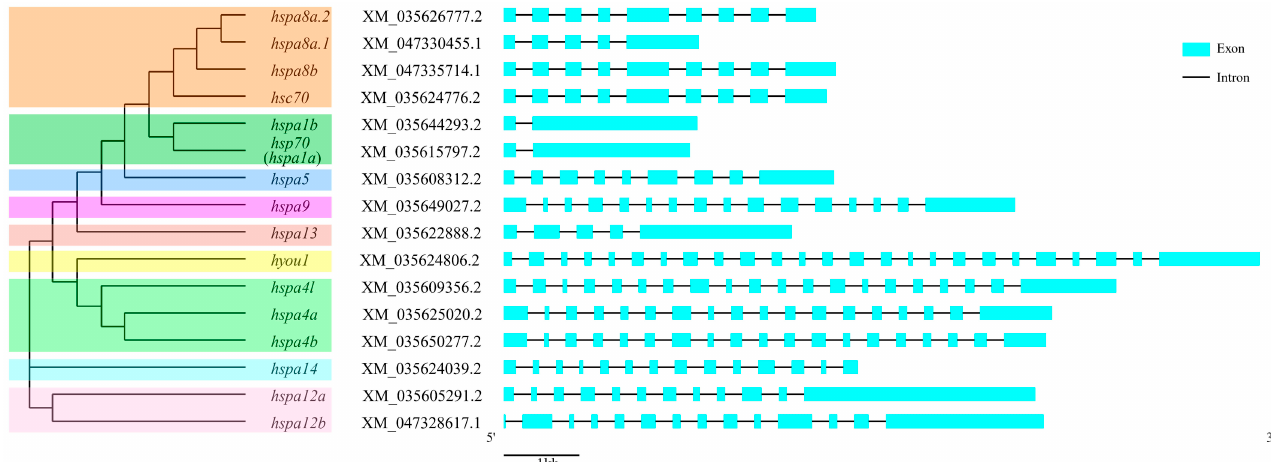
Figure 3. The combination of phylogenetic relationship and exon–intron structure. The left of the graph shows the phylogenetic relationships of S. maximu HSP70 genes. The right of the graph shows exon–intron structure and the length of introns of each HSP70 genes are displayed in the same length.